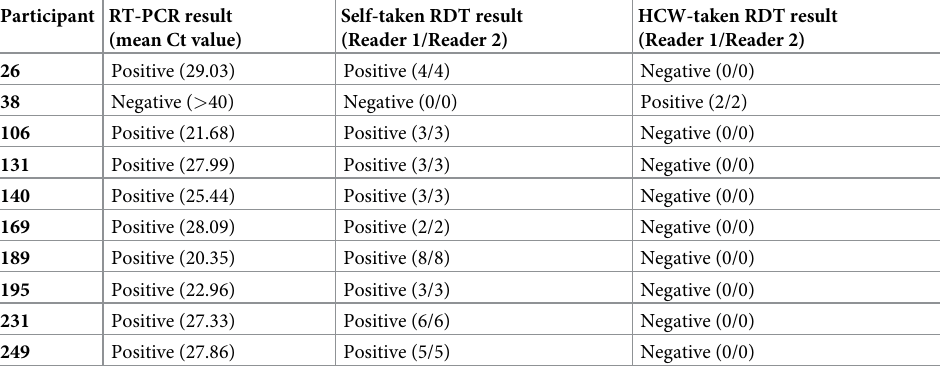
Table 3. Table showing full results for participants with discrepant RDT results.